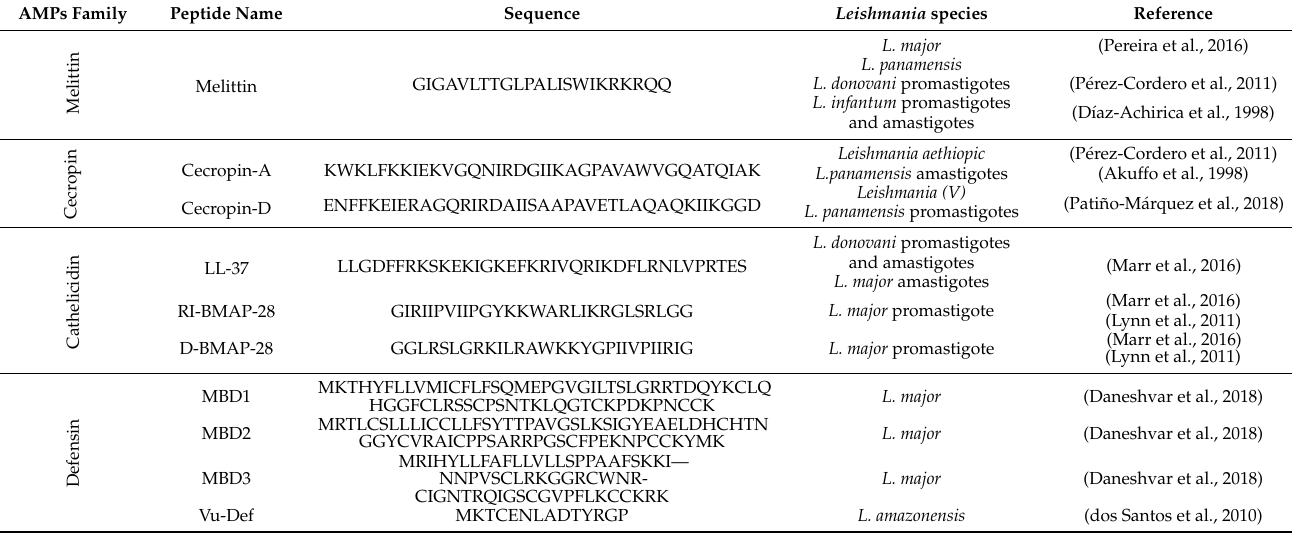
Table 1. Some AMPs exhibiting leishmanicidal